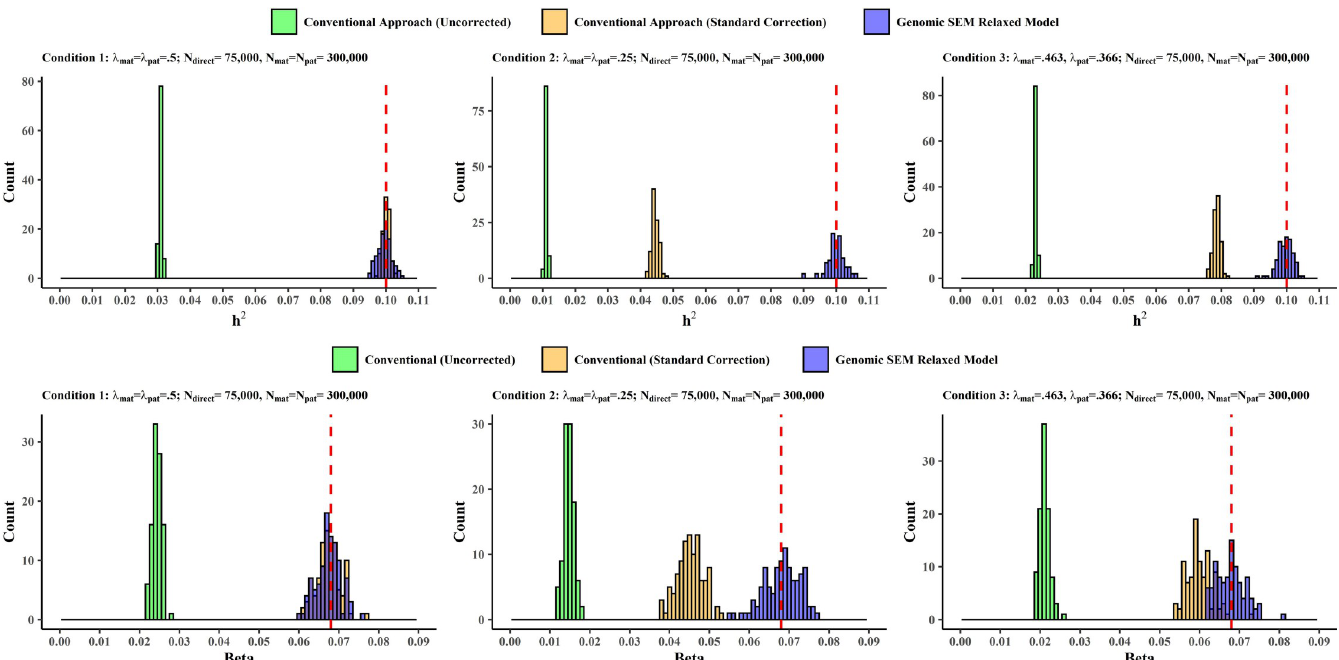
Fig 1. Simulation Results for continuous phenotypes. Distribution of SNP heritability estimates (top row) and individual SNP effects (bottom row) for Conventional (Uncorrected), Conventional (Standard Correction), and Genomic SEM Relaxed Model across conditions. The vertical dashed red lines indicate the true parameter value in the population. Complete simulation results for all conditions for continuous traits are reported in S2, S3, S10 and S11